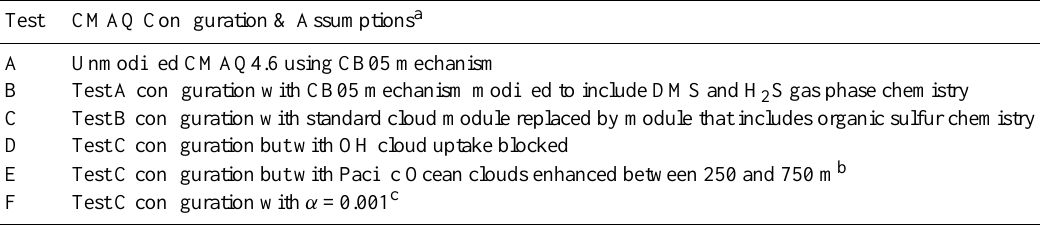
Table 7. Average simulated winter and summer natural pollutant levels for the modeling domain.